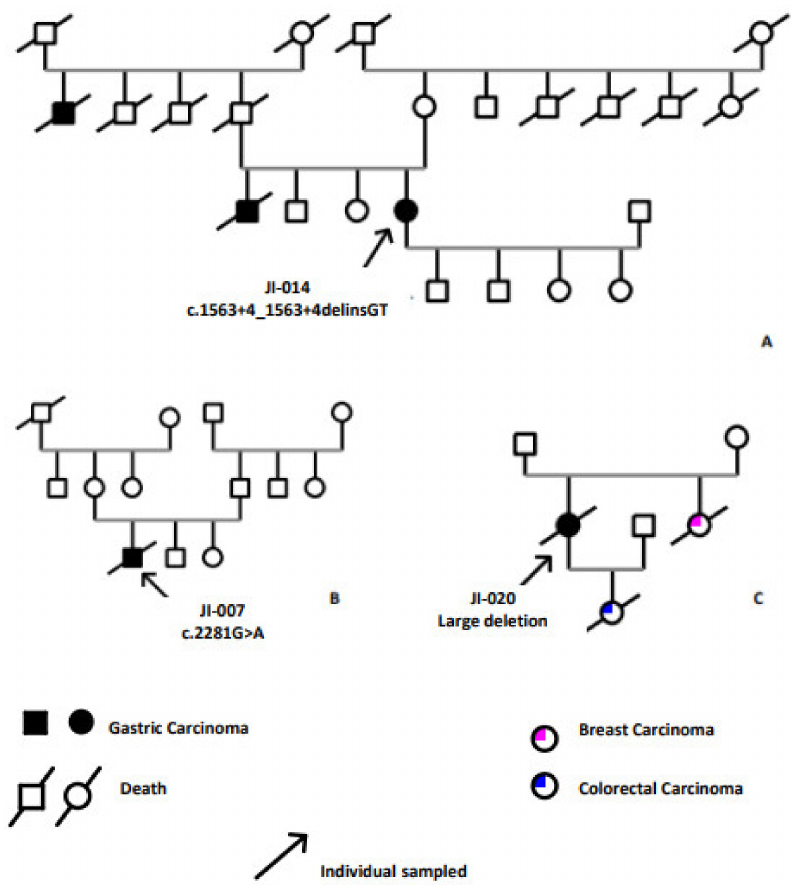
Figure 1. Family history of index cases carrying selected variants. ( A ) Family history of “JI-014” harboring the novel Indel variant c.1563 + 3_1563 + 4delinsGT located in intron 10, predicted to be probably pathogenic. ( B ) Family history of “JI-007” harboring the missense variant c.2281 G > A at exon 14 of the CDH1 gene, classified as a VUS in the ClinVar database. ( C ) Familial history of “JI-020” carrying the large deletion of two exons (one and two) identified by MLPA assay.